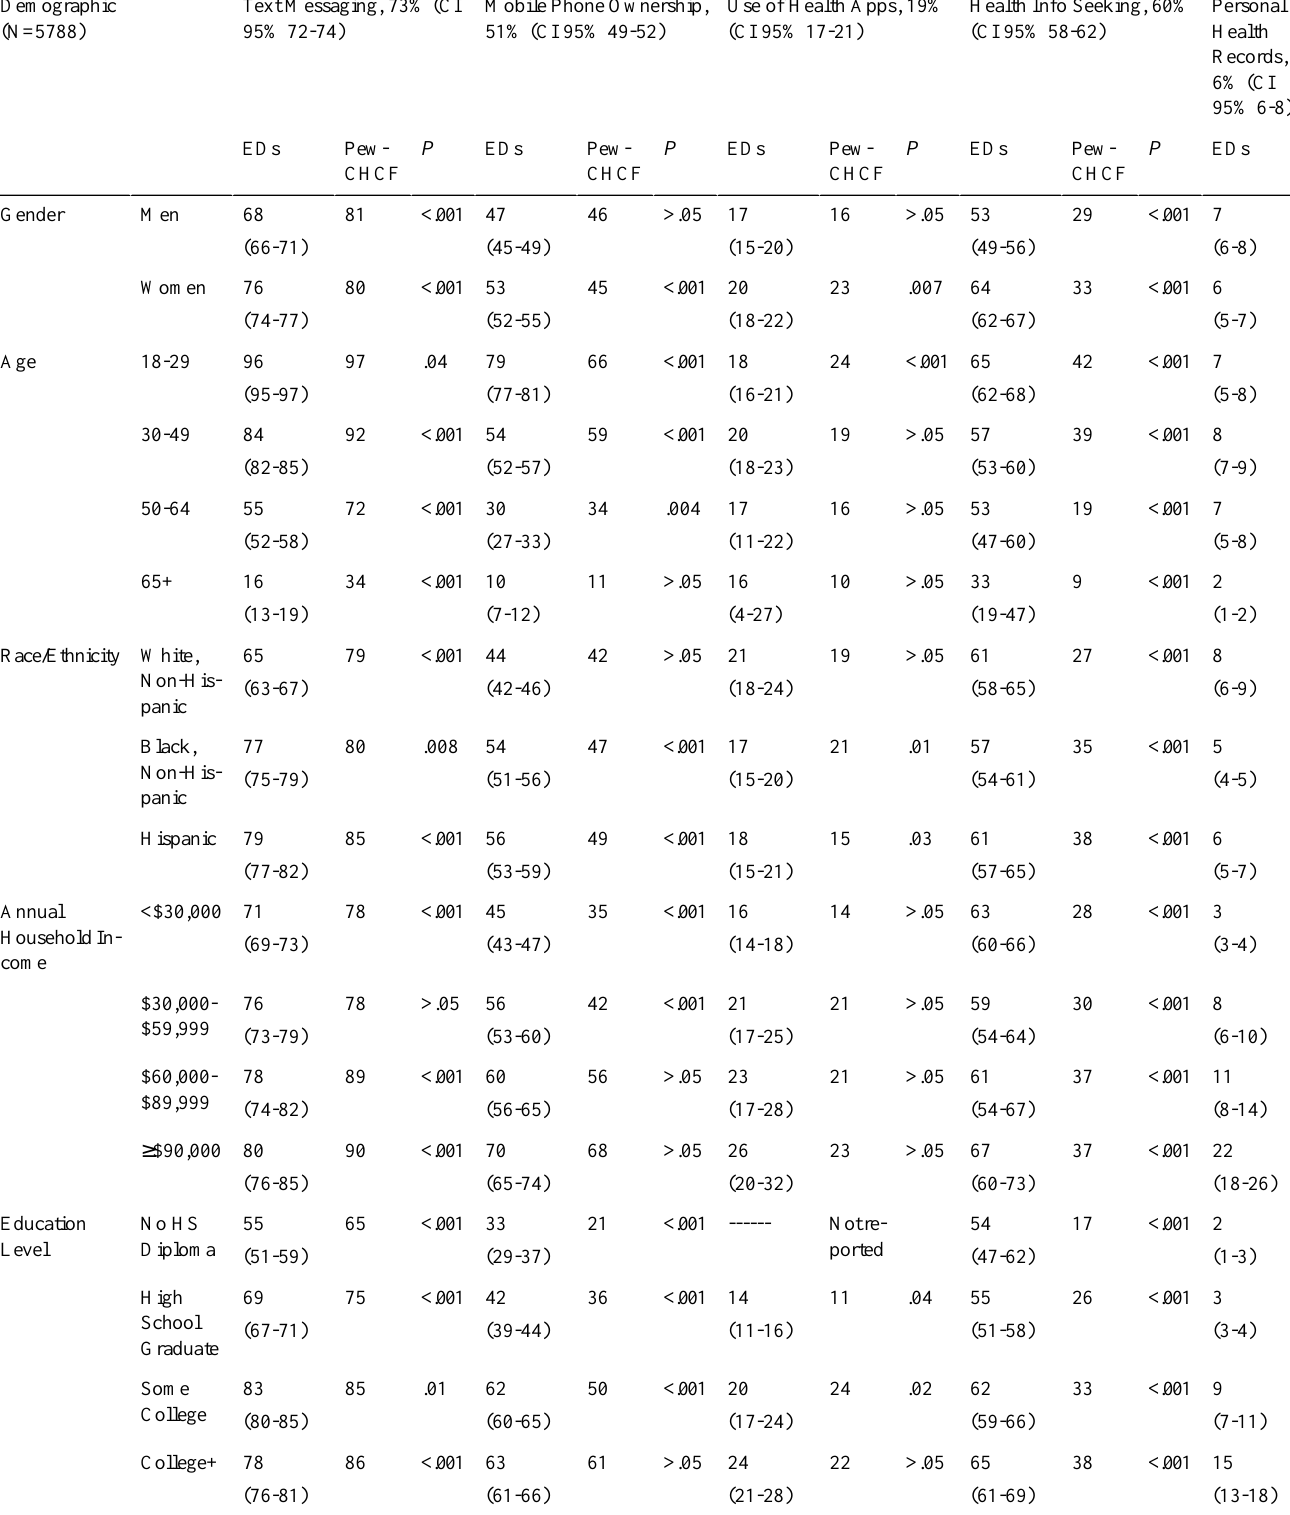
Table 3. New media device ownership and use by ED survey participants versus Pew-CHCF study data, July 12 to August 30,